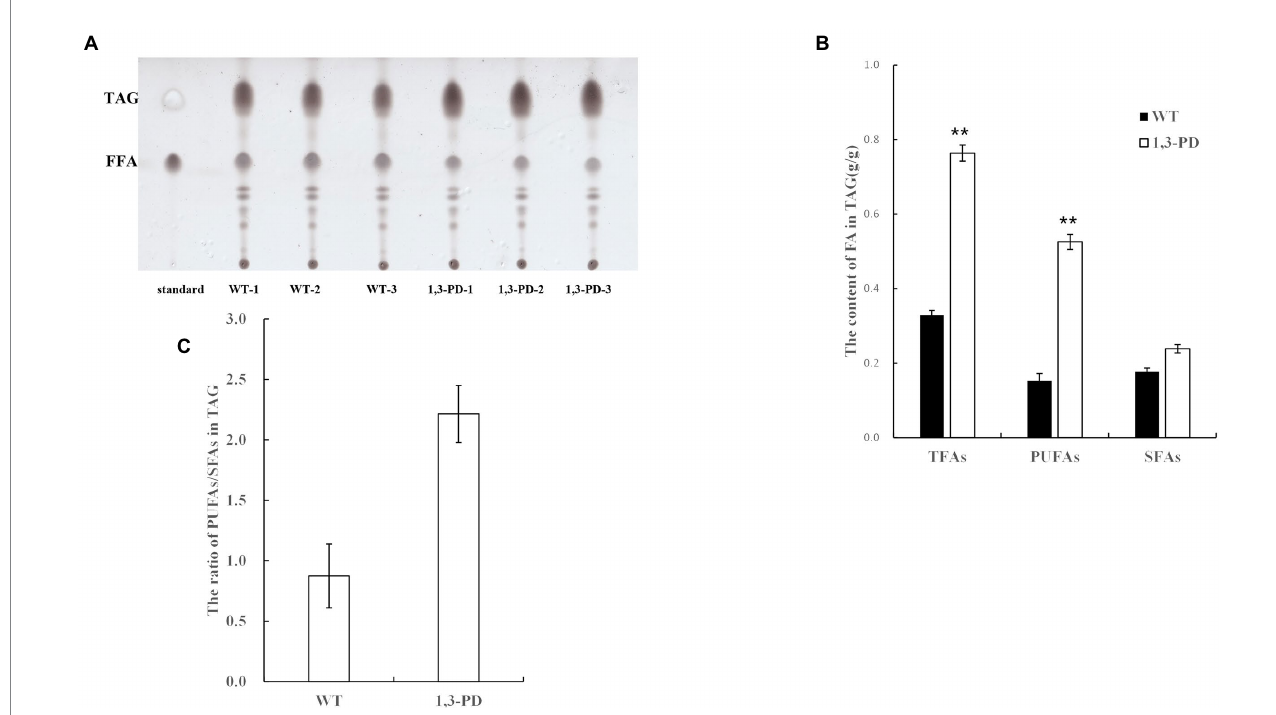
FIGURE 5 Comparison of the content and fatty acid profiles of triacylglycerol (TAG) with/without supplementing 1,3-PD. (A) The separation result of lipid by TLC. (B) The contents of FA in triacylglycerol. (C) The ratio of PUFAs/SFAs in triacylglycerol. * p -value <0.1 ** p -value <0.05 *** p -value